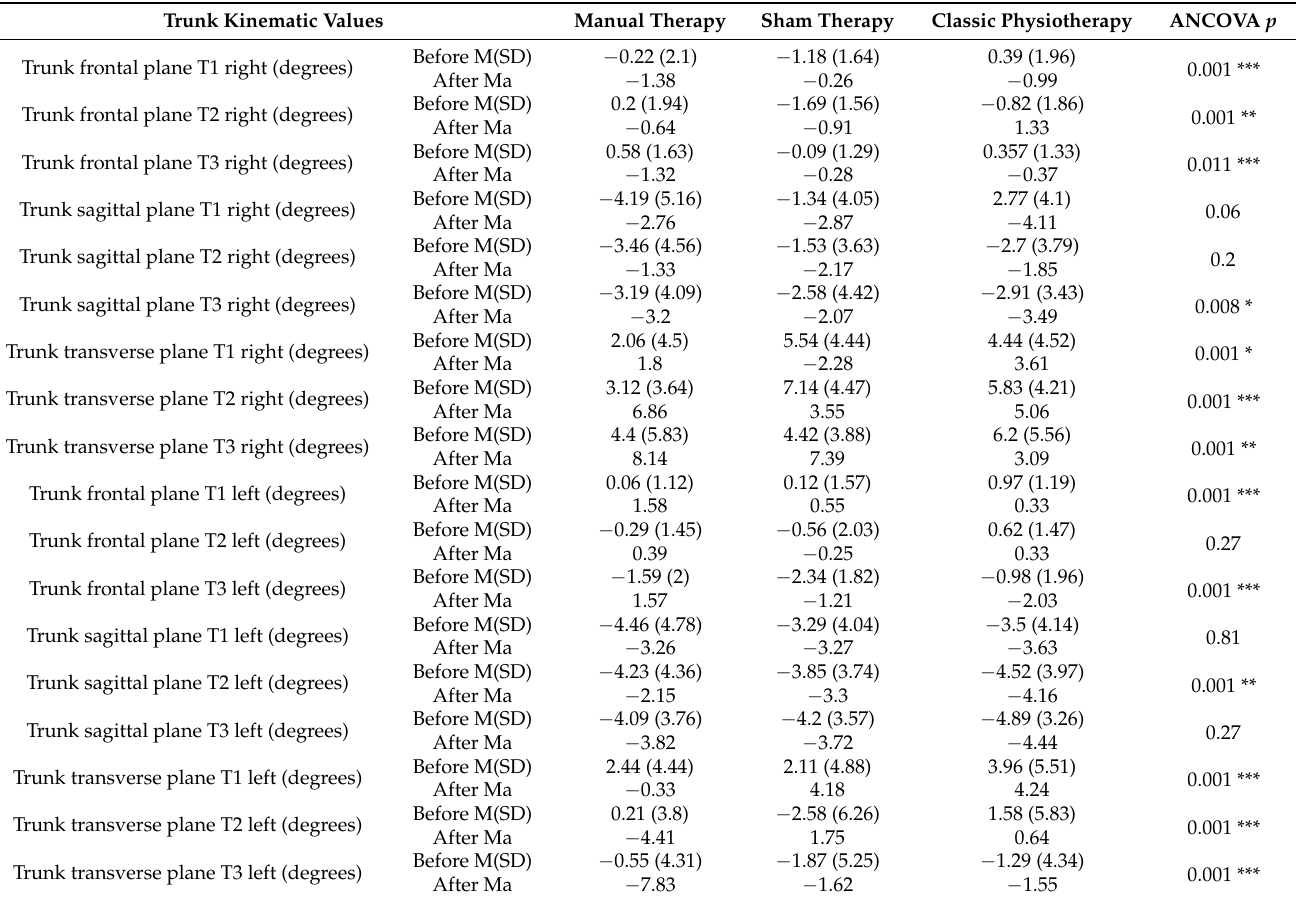
Table A2. ANCOVA results in trunk kinematics.